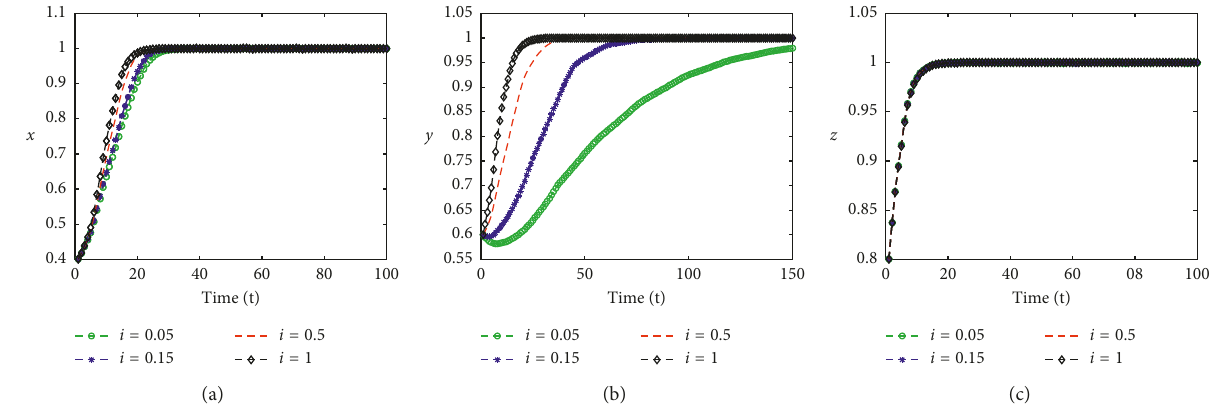
Figure 9: The effect of external investors’ return rate on the evolutionary